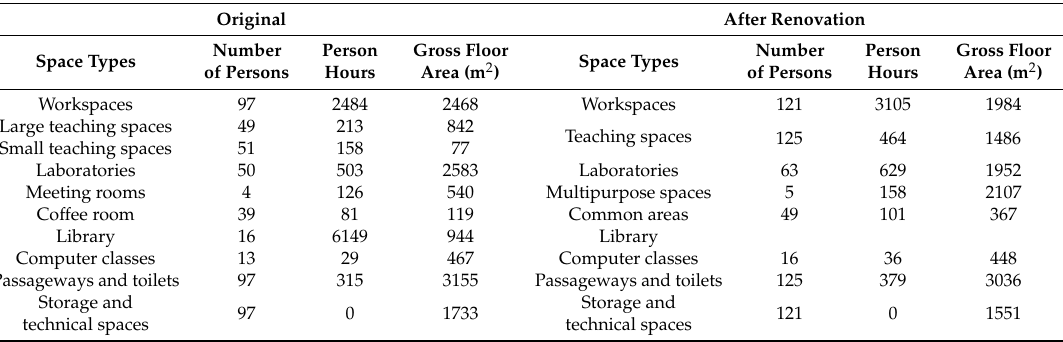
Table 2. The main functions of the building and their floor areas and person hours in the original plan and in the plan after